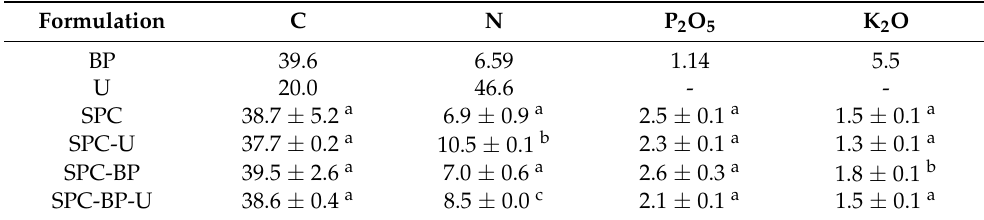
Table 1. Total C, N, P, and K concentrations (%, w / w ) in neat sunflower protein concentrate (SPC), biopolymer (BP), urea (U), and in the SPC pellets’ samples 1 .